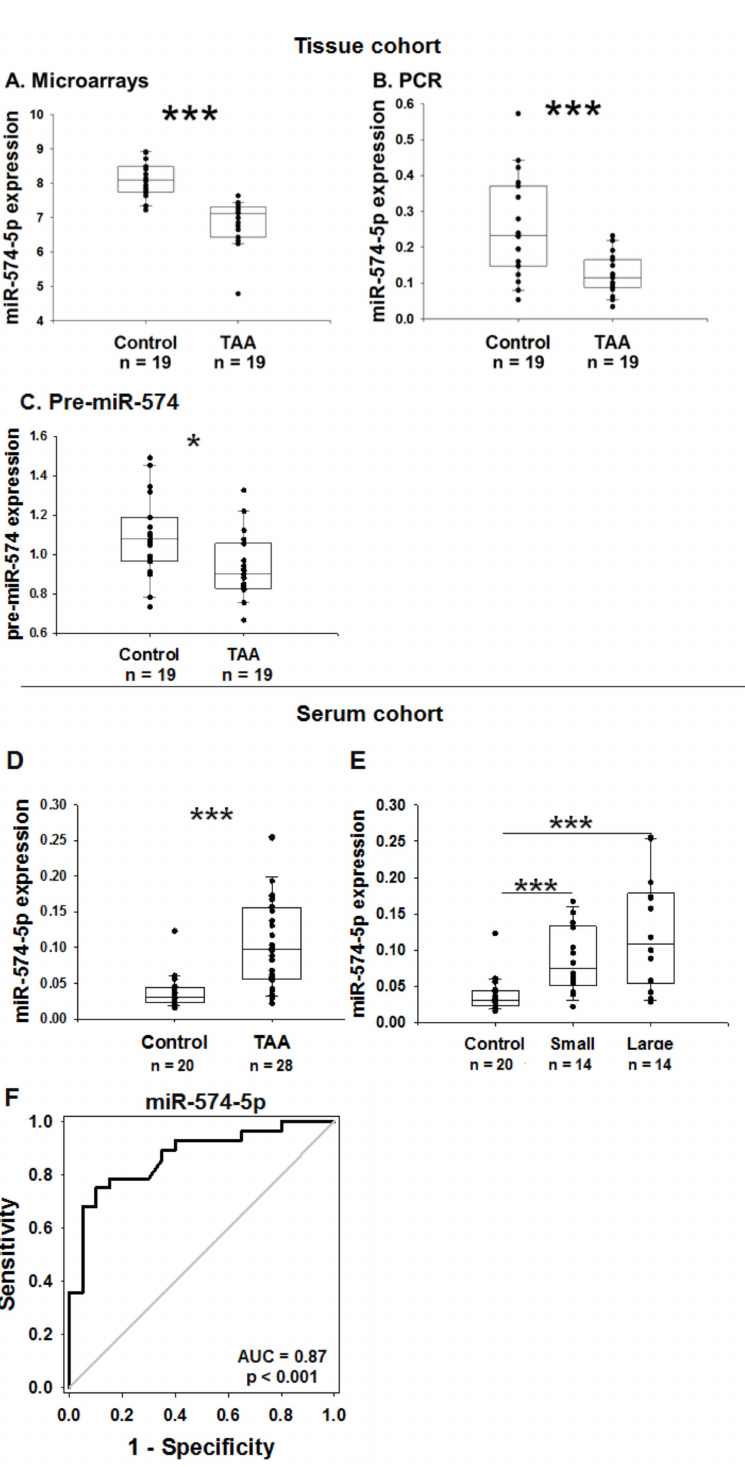
Figure 2. MiR-574-5p and pre-miR-574 expression in aortic tissues from the tissue cohort ( A – C ); and the association between serum levels of miR-574-5p and TAA in the serum cohort ( D – F ). ( A ) Microarray data. ( B , C ) Quantitative PCR data. * p < 0.05, *** p < 0.001 versus control. ( D ) Expression of miR-574-5p in the serum of TAA and control patients from the serum cohort. ( E ) Expression of miR-574-5p according to the size of the aneurysm. The small group includes patients with an aneurysm < 49 mm and the large group includes patients with an aneurysm > 49 mm. TAA: Thoracic aortic aneurysm. *** p < 0.001. ( F ) ROC (receiver operating characteristic) curve analysis showing the association between serum levels of miR-574-5p and TAA. AUC: Area under the